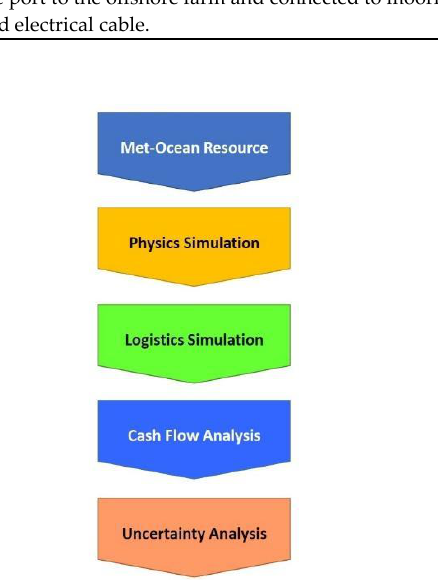
Fig. 3. Overview of the Wave Venture TE™ software.